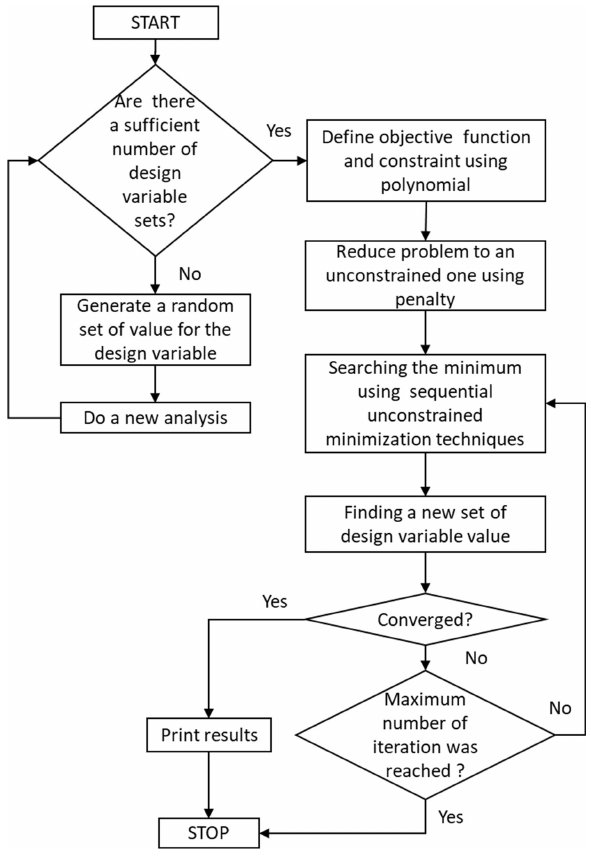
Figure 2: General flow chart for the optimization of a Stockbridge damper